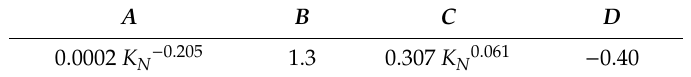
Table 2. Revised coe ffi cients entering in the limit Equations (4) and (5) as functions of K N .